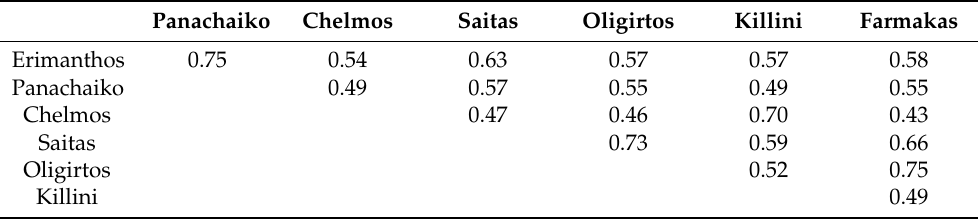
Table 3. Pairwise comparison of the Greek endemic flora of Mts. Erimanthos, Panachaiko, Chelmos, Saitas, Oligirtos, Killini, and Farmakas by means of the Sørensen similarity index. Panachaiko Chelmos Saitas Oligirtos Killini